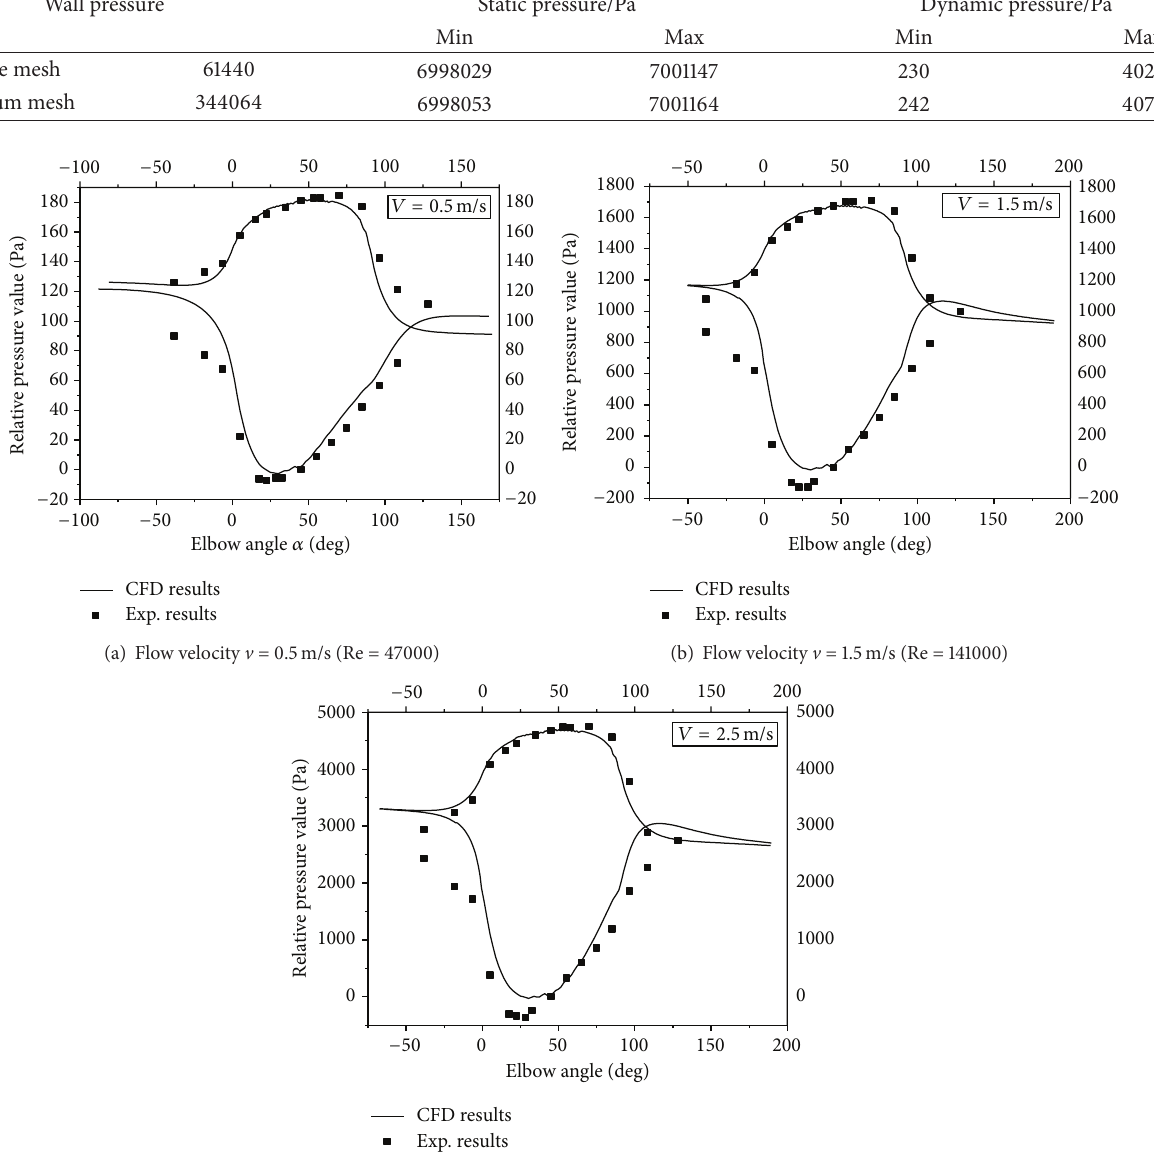
Table 1: Grid sensitivity between coarse mesh and medium mesh.